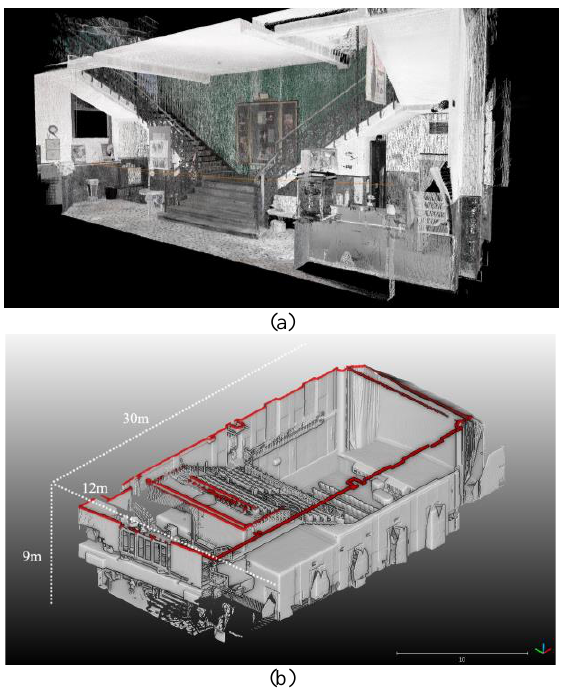
Figure 2. The preview of the Swift data on the XX century cinema, with indication of the main